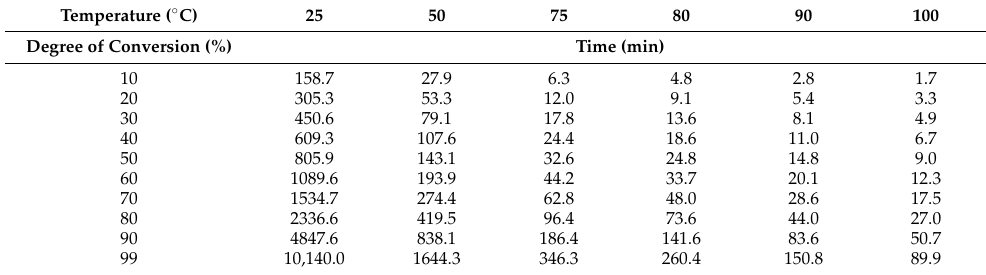
Table 4. Isothermal process simulation at different temperatures for the epoxy resin.